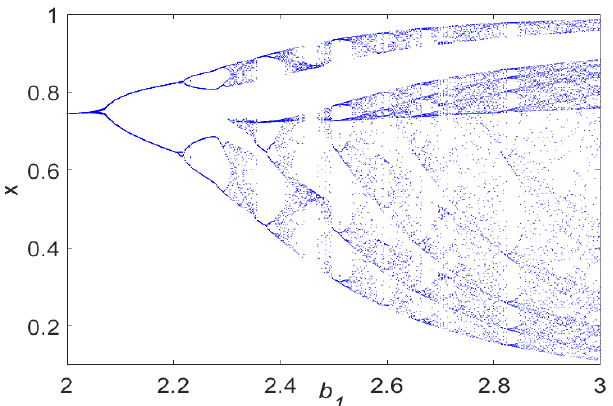
Figure 3. The bifurcation diagram with the varying parameter b 1